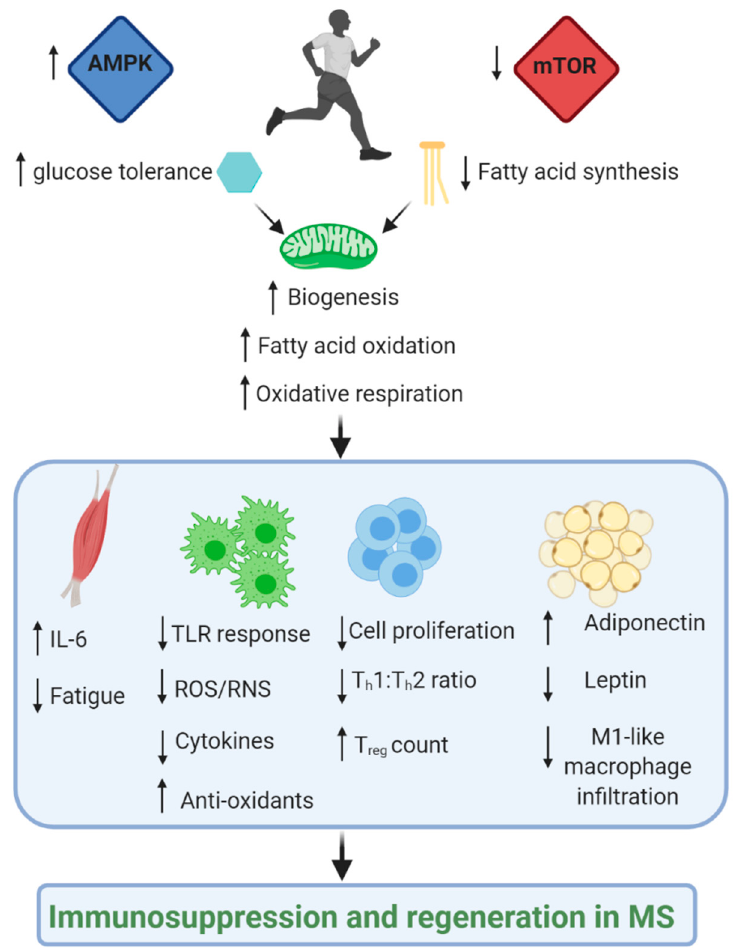
Figure 6. Impact of exercise on immune-inflammatory response and metabolic function. Regular aerobic / endurance exercise has shown to induce a tolerogenic glucose state, which is associated with a state of immunomodulation through changes in amino acid metabolism (e.g., increased kyunrenic acid and glutamate oxidation) and nutrient sensor pathways (increased AMPK:mTOR ratio). This induces increases mitochondrial biogenesis and oxidative respiration at the mitochondria at least partly through increased fatty acid oxidation (FAO) and decreased fatty acid synthesis (FAS). This impacts on various organs and cells, including (1) higher myokine IL-6 secretion by skeletal muscle tissue; (2) Decreased proinflammatory macrophage and e ff ector T cell number and cytotoxic activity; (3) Decreased ROS and proinflammatory cytokine production by innate immune cells, as well as an increased antioxidant response; (4) increase in T reg number and function; (5) decrease in leptin secretion (likely due to reduced fat mass) and increase in adiponectin secretion, and lower proinflammatory M1-like macrophage infiltration. Image made in Biorender TM.